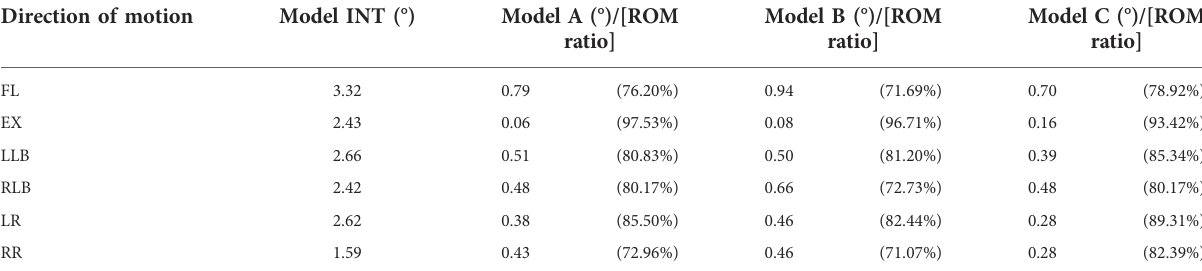
TABLE 2 Lumbar spine range of motion under each working condition of the four models. Direction of